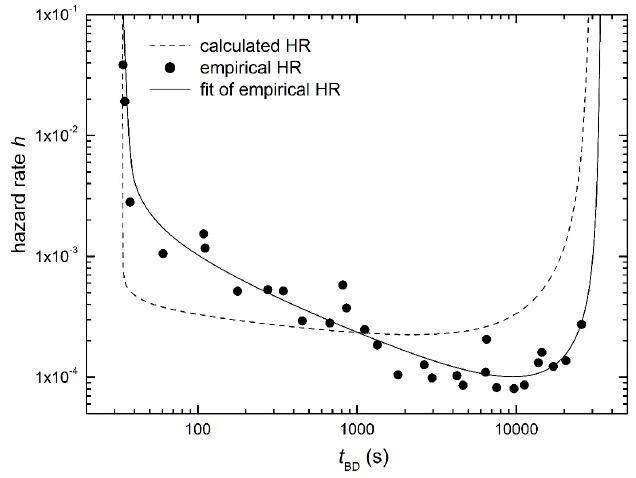
Figure 3. Figure 2 in a more suitable log–log plot. Dissimilar lines in Figures 2 and 3 (dashed lines vs. solid lines) show that the fit of the Weibull plot using the (W4) CDF and the fit of the empirical HR using Equation (17) lead to different values of distribution parameters. As presented in Table 1, all parameters